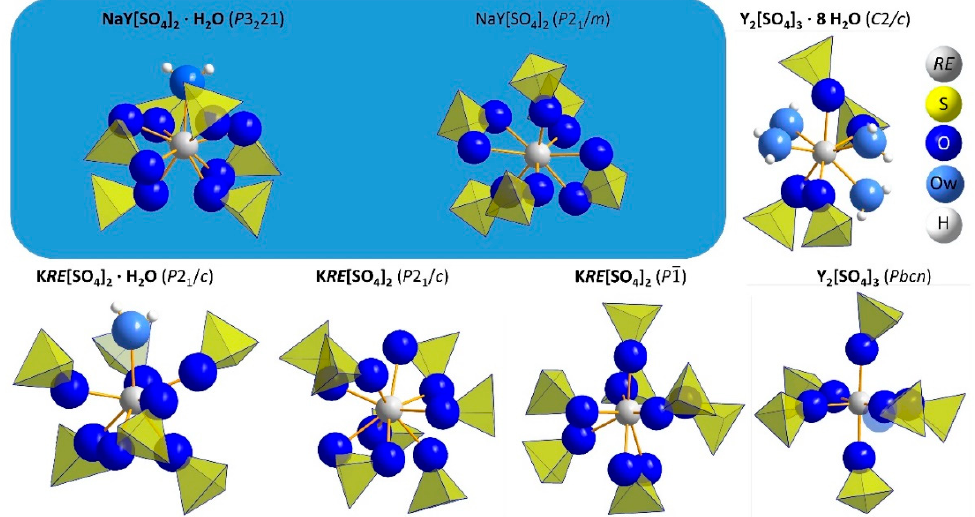
Figure 5. Coordination spheres of the RE 3+ cations in different rare-earth metal oxosulfates. The blue box contains the title compounds NaY[SO 4 ] 2 ∙ H 2 O and NaY[SO 4 ] 2 .